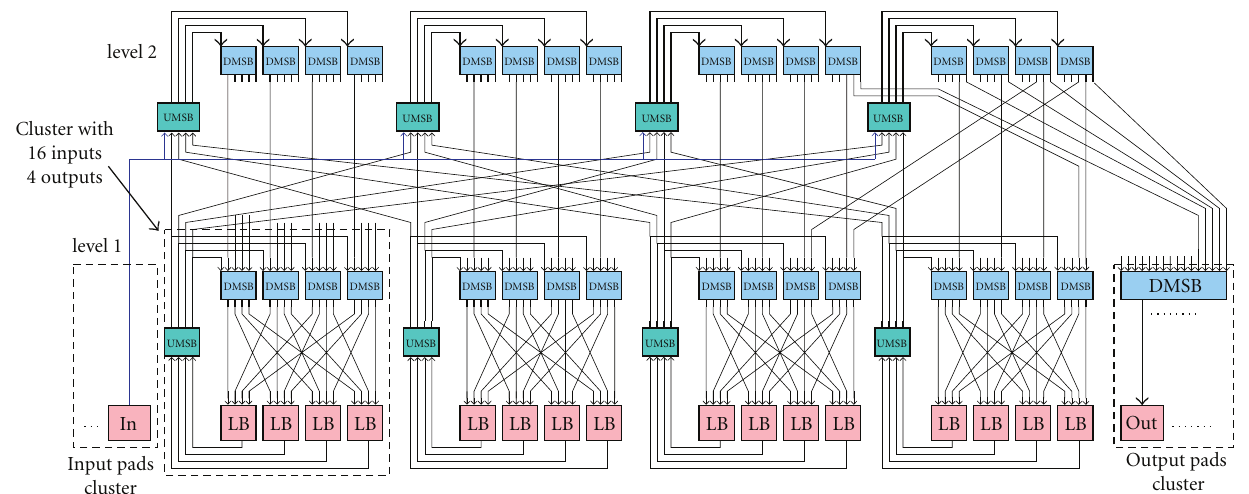
Figure 1: Tree-based interconnect: upward and downward